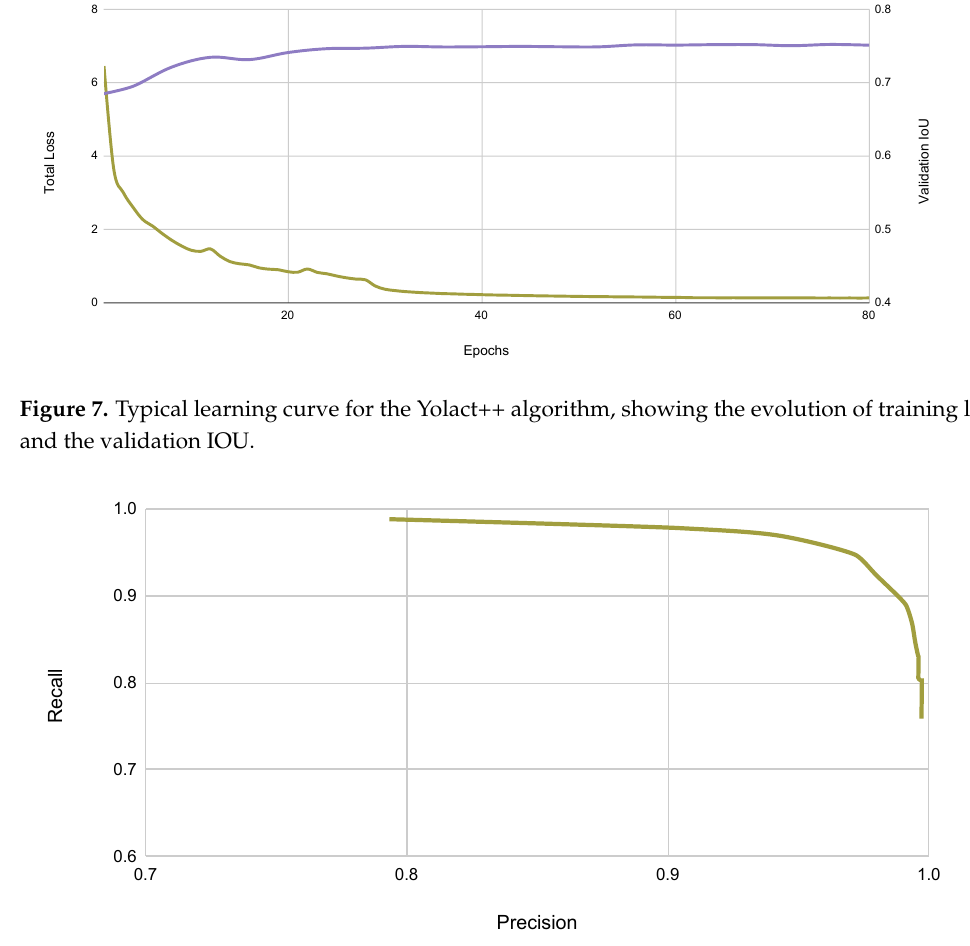
Figure 8. Typical precision–recall curve for the Yolact++ algorithm on the maritime dataset.